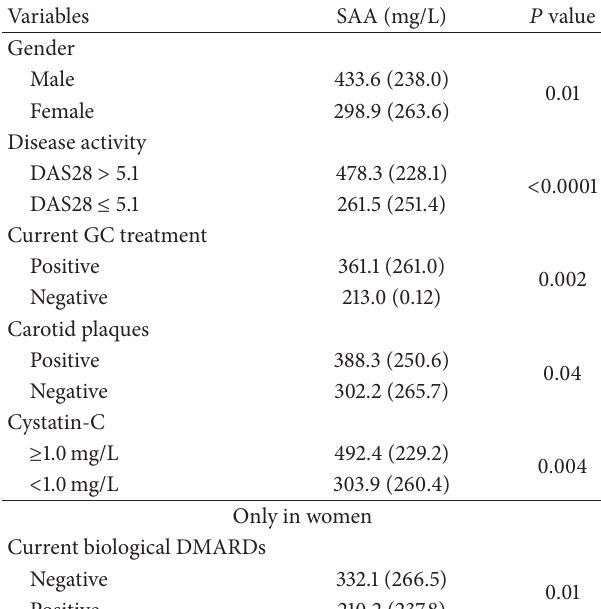
Table 4: Significant differences in SAA concentration between groups of RA